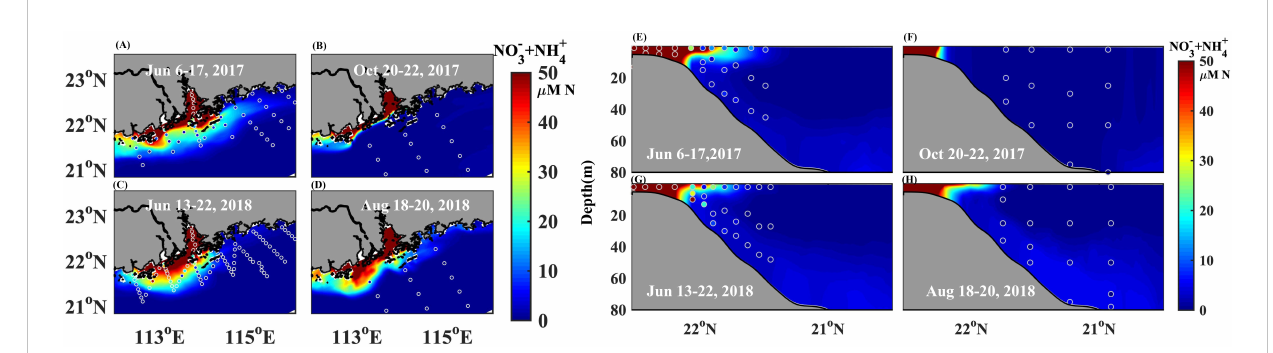
FIGURE 7 Comparison between observed and simulated nitrogen type nutrients (NO 3 + NO 2 + NH 4 ) for the surface (A – D) and along vertical transect (E – H) for datasets (3) to